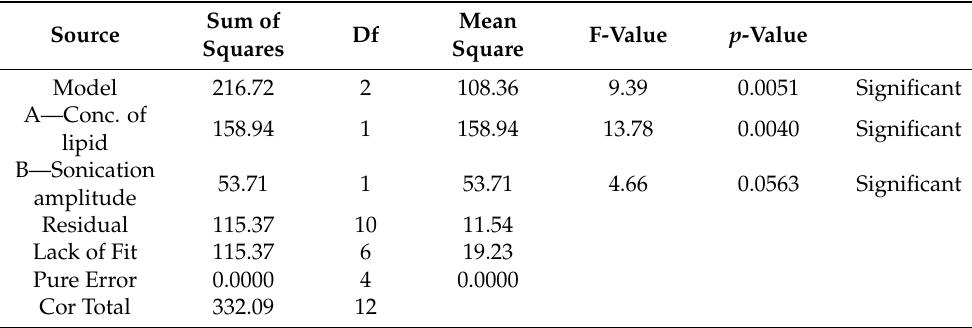
Table 3. ANOVA for the linear model of the entrapment efficiency of BP-LCN